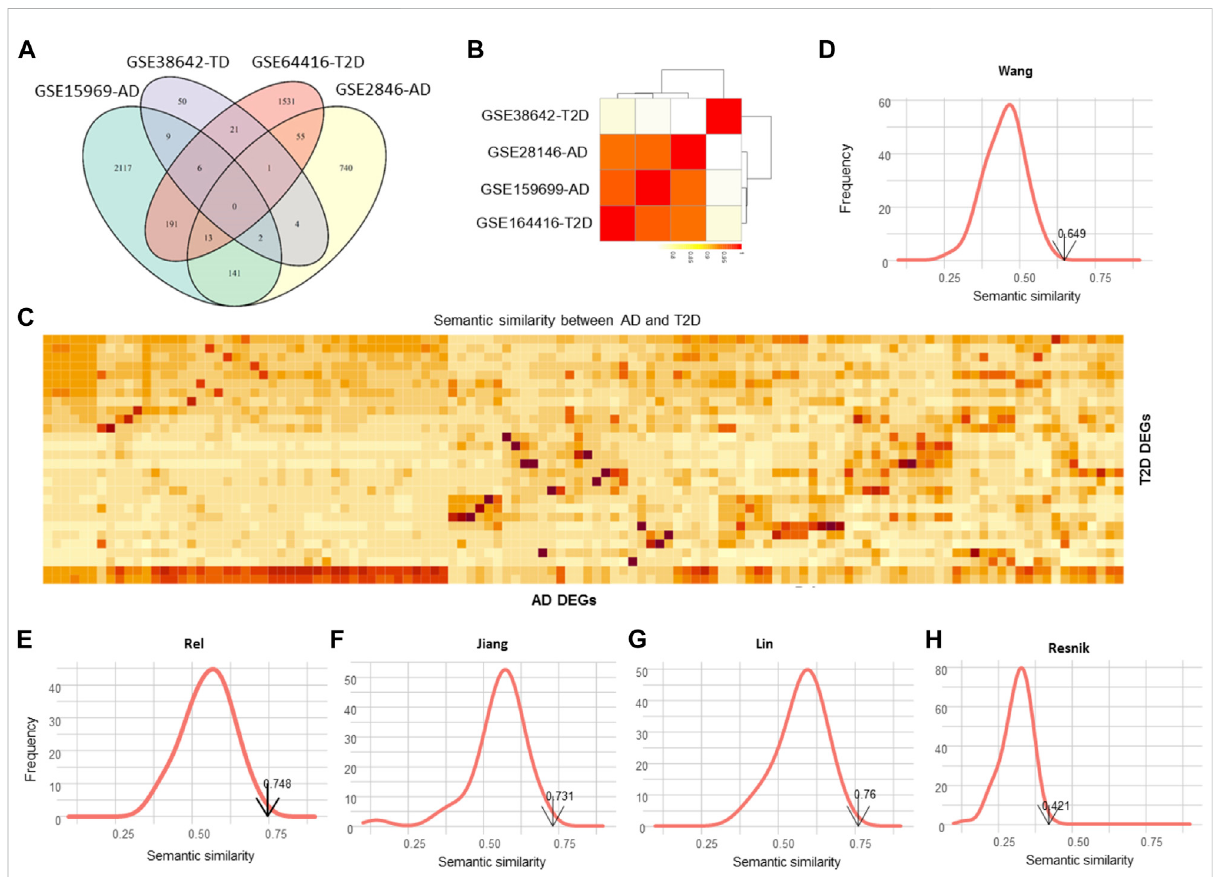
FIGURE 3 Evaluation of the functional similarity between AD and T2DM. (A) Venn diagram illustrating the DEGs identi fi ed from GSE159699, GSE28146, GSE38642 and GSE164416. (B) Semantic similarity among the DEGs of the four datasets. (C) Heatmap showing the semantic similarity between AD andT2DMDEGs. (D – H) DistributionsofthesimulatedsemanticsimilarityforWang,Rel,Jiang,LinandResnik.Thesimulatedscoresaregenerallyless than the detected